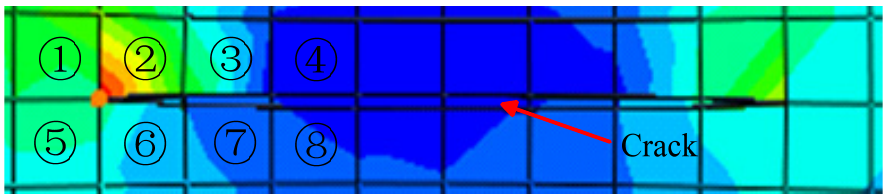
Figure 17. Element distribution of the stress field near the crack tip for observation (The colors represent the intensity of the stress field, the red represents the largest, the blue represents the smallest).